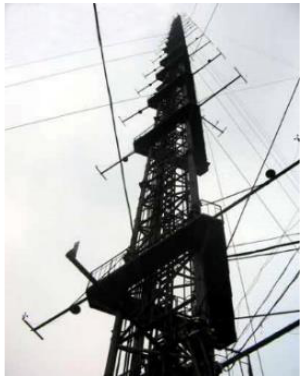
Figure 4. Beijing 325-m-high meteorological tower.